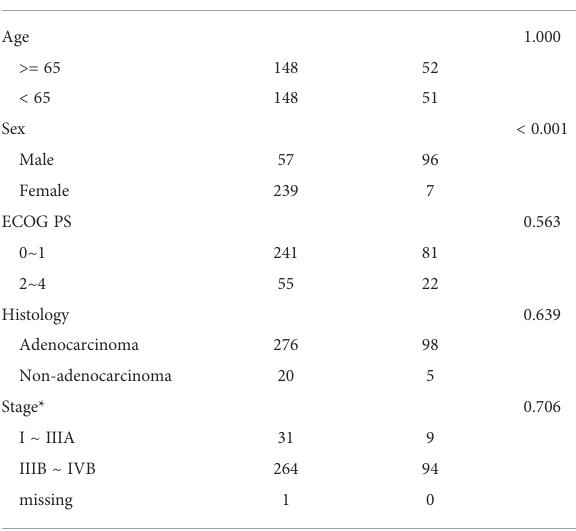
TABLE 3 Baseline characteristics of never and ever smokers harboring uncommon EGFR mutations. Characteristic, N (%) Never-smoker Ever-smoker p